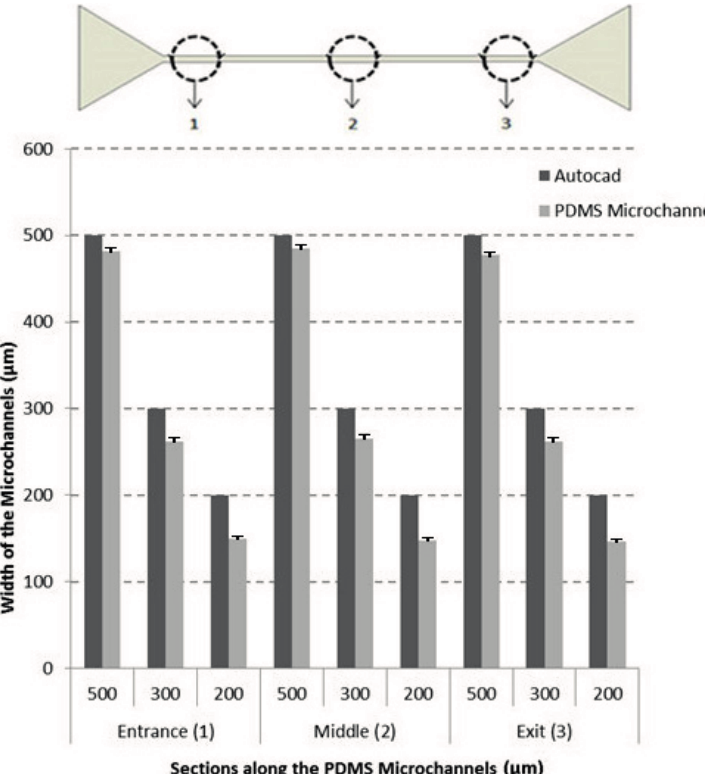
Figure 7. Comparison between the values projected from AutoCAD and width measurements of the PDMS microchannels at three different sections: entrance ( 1 ), middle ( 2 ), and exit ( 3 ). The measurements are expressed as the mean ± standard deviation according to a t -test analysis at 95% confidence interval.